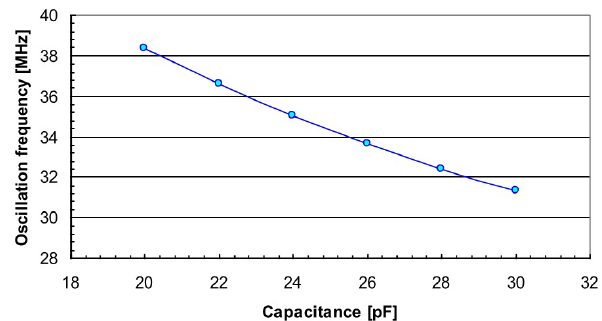
Figure 25. Predicted first harmonic oscillation frequency of the lambda diode oscillator when its tuning circuit contains the design 3 capacitive pressure sensor and the loop antenna of Fig. 24.